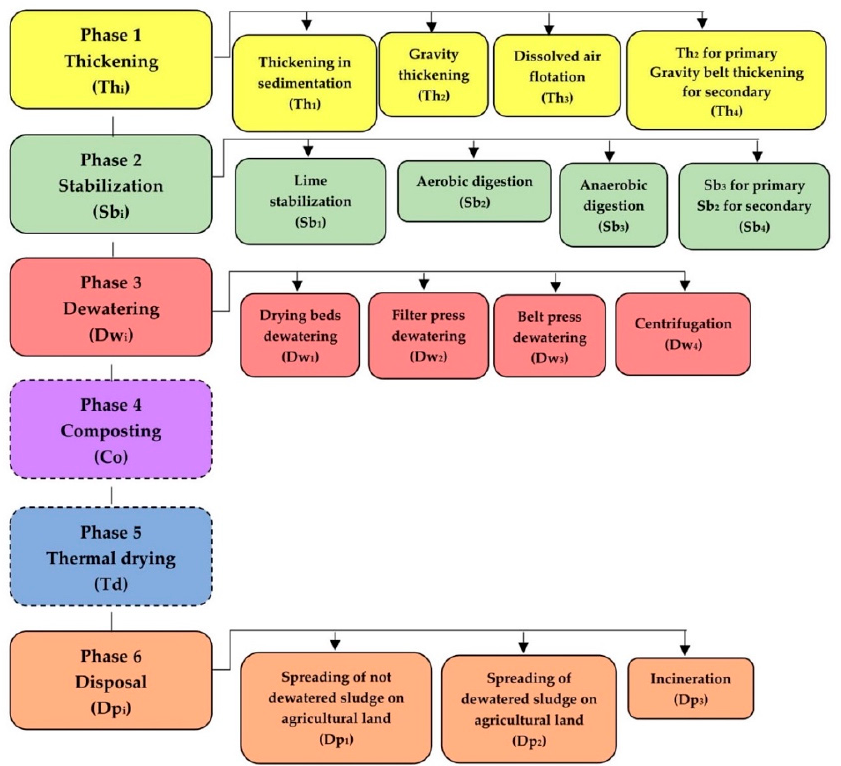
Figure 3. Summary of the unit operations for each phase of the SSTS. The ANN model neglects the alternatives available to carry out the phases included in the boxes with the dashed line.